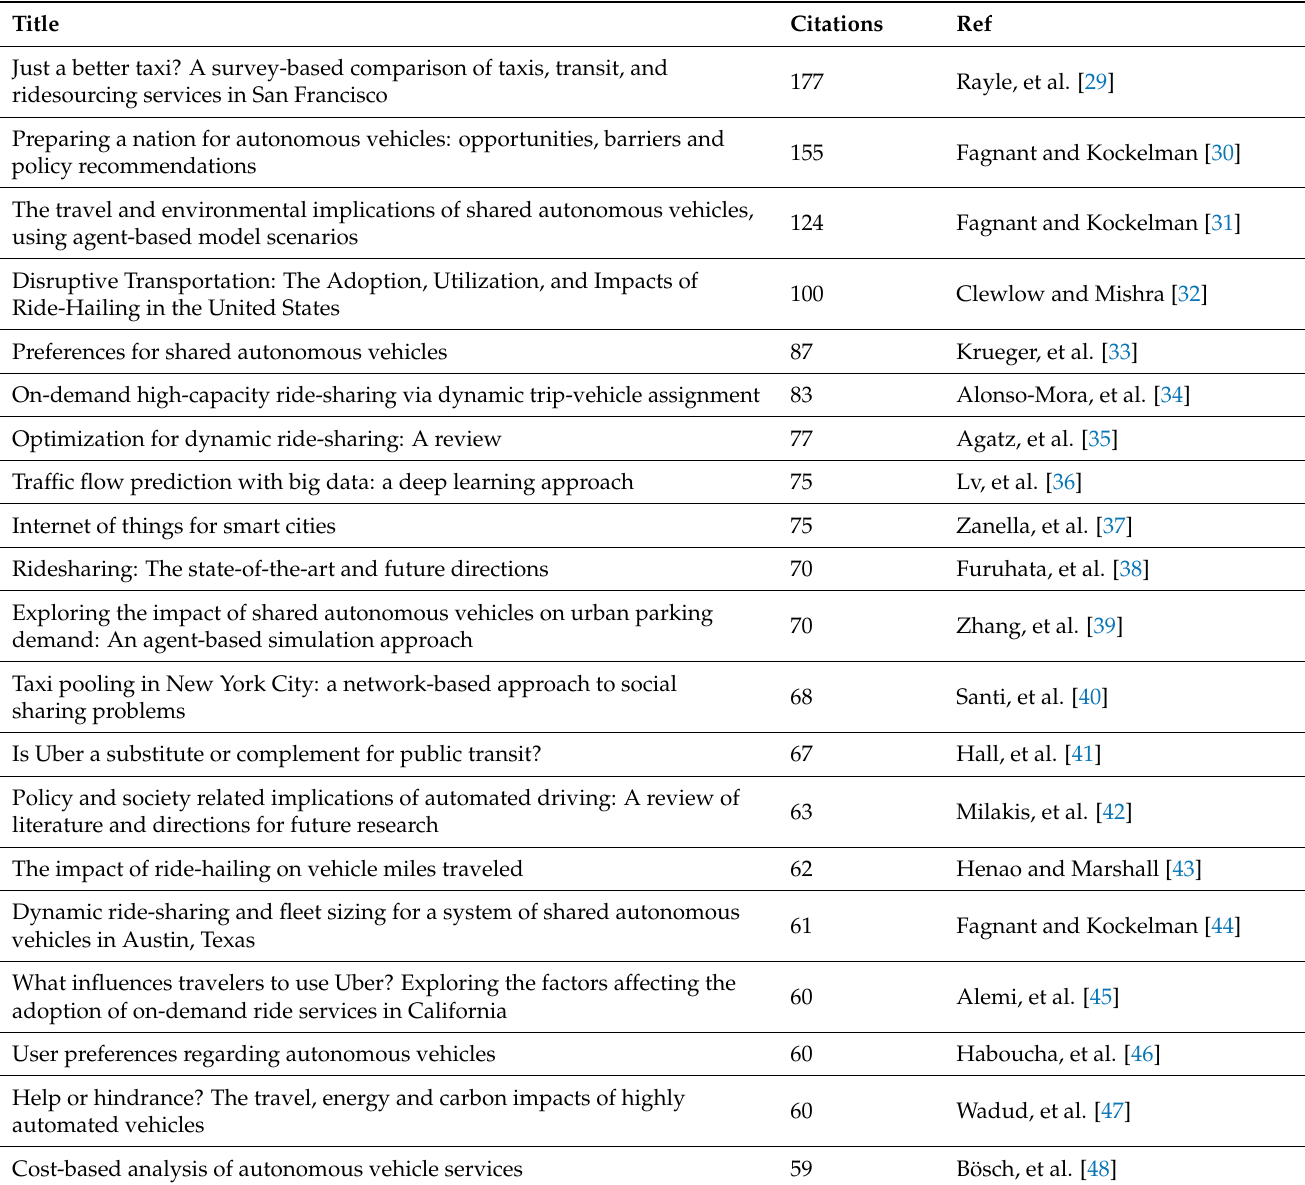
Table 1. Influential references on the theme of Smart Urban